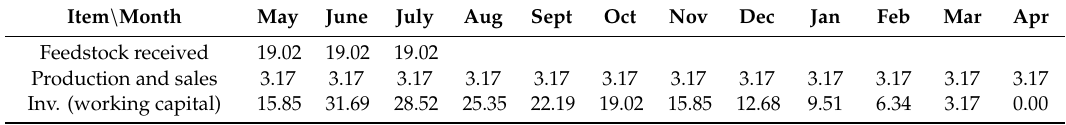
Table 4. Inventory projections during a typical year for the crushing facility in USD